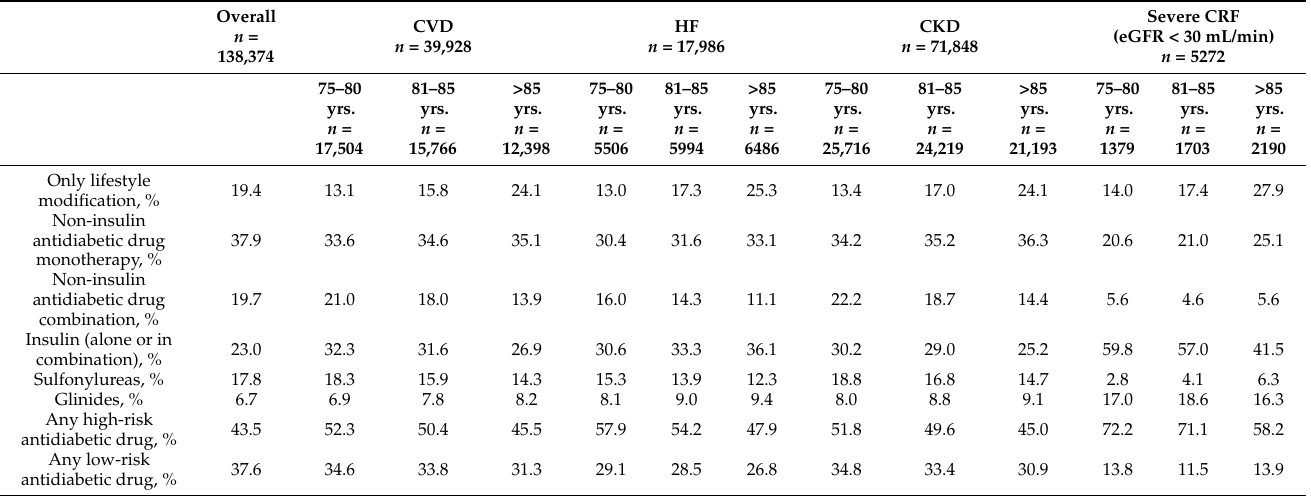
Table 2. Steps of treatment and use of antidiabetic drugs by age subgroups and the presence of